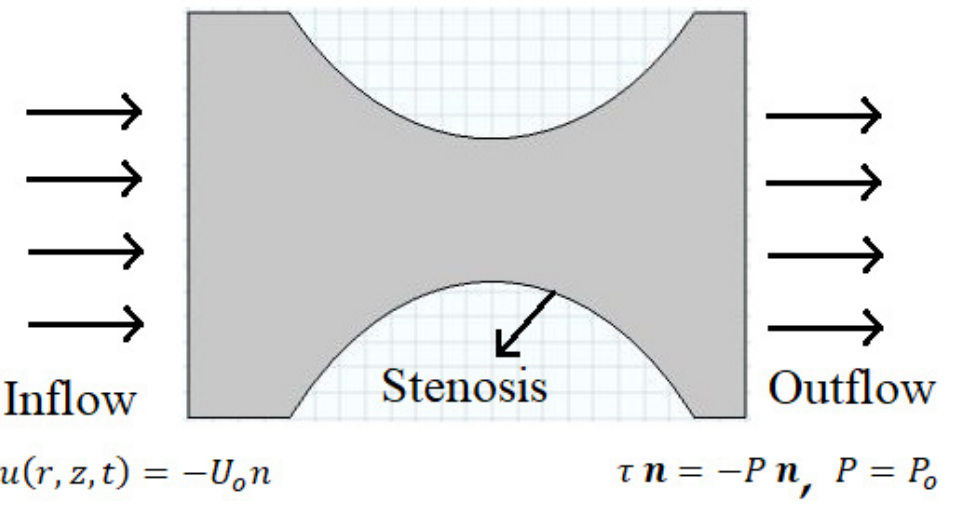
Figure 1. The geometry of arterial stenosis.